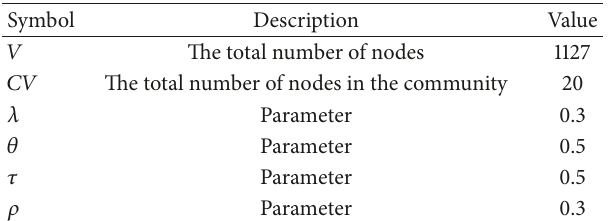
Table 5: Parameters for